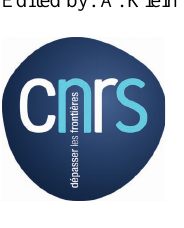
Meteorological Research Center (weather observation), the Na- 42 tional Snow and Ice Data Center (satellite data) and the Baseline Surface Radiation Network (radiation observations). We also thank C. Genthon and D. Six, LGGE, for the disdrometer data. Edited by: A.